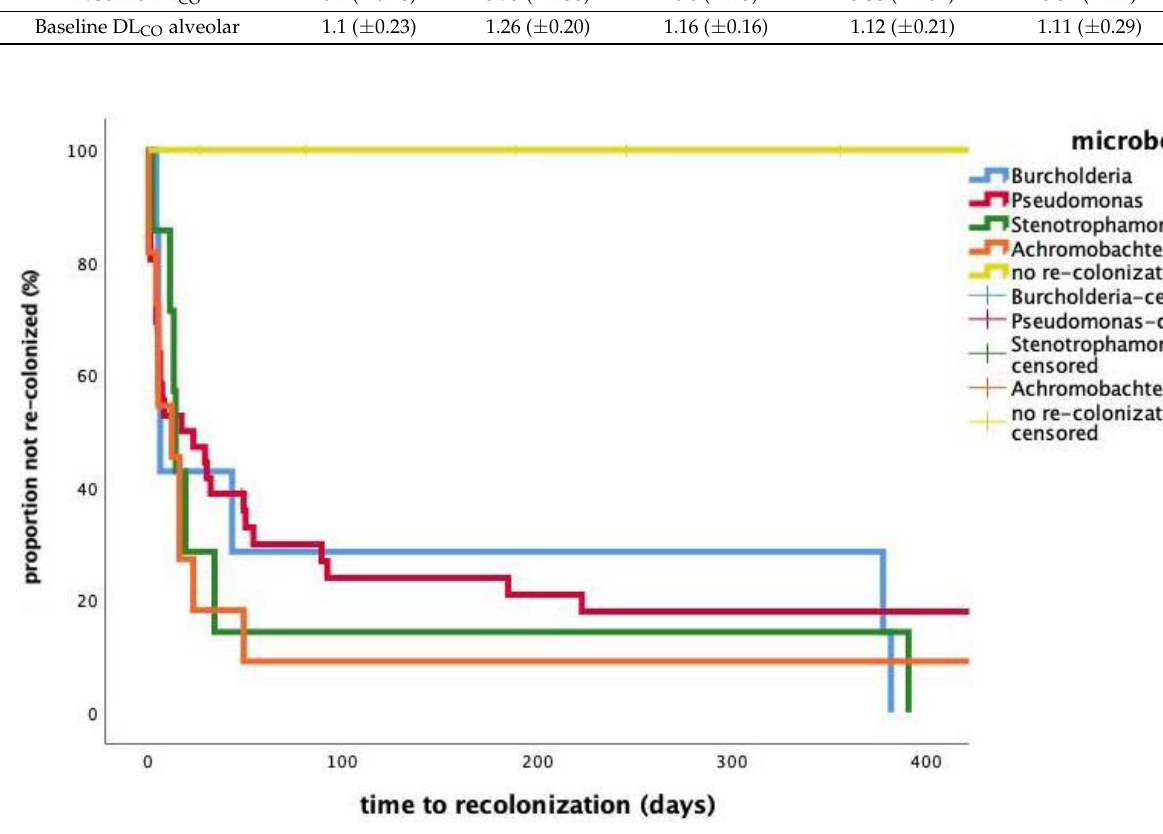
Figure 2. Kaplan–Meyer plot showing time from transplantation to re-colonization.